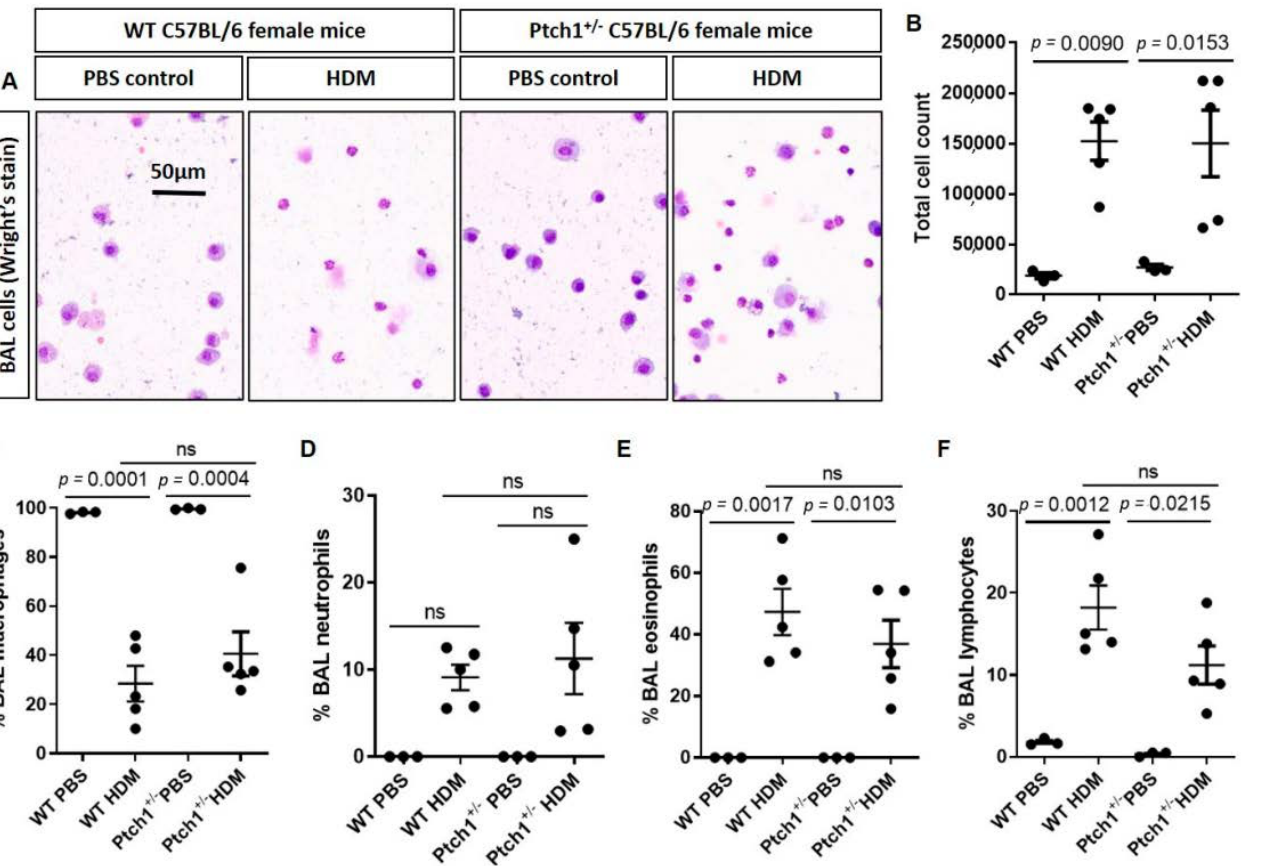
Figure 7. Differential cell counts from broncho − alveolar lavage (BAL) fluid were profiled in WT and Ptch1 +/ − mice with or without HDM exposure. ( A ) Representative images of cells stained with Wright’s stain from BAL of WT and Ptch1 +/ − mice with or without HDM exposure were shown. Scale bar = 50 µ m. ( B ) Total cell count, ( C ) % macrophages, ( D ) % neutrophils, ( E ) % eosinophils and ( F ) % lymphocytes from BAL were quantified. One-way analysis of variance with Bonferroni’s multiple comparisons test was used in panels ( B – F